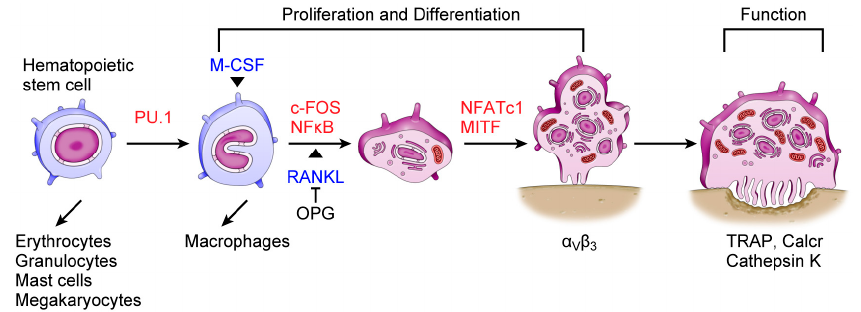
Figure 1. Schematic view of osteoclast differentiation. Osteoclasts are derived from hematopoietic stem cells. Cytokines macrophage colony-stimulating factor (M-CSF) and receptor activator of nuclear factor κ B ligand (RANKL) are essential for osteoclastogenesis. Binding of RANKL to its receptor, receptor activator of nuclear factor κ B (RANK), activates nuclear factor of activated T cells, cytoplasmic 1 (NFATc1), which is a master regulator of osteoclastogenesis. NFATc1 works with other transcription factors, such as activator protein-1 (AP-1), PU.1, and microphthalmia-associated transcription factor (MITF) to induce various osteoclast-specific genes, such as TRAP, Calcr, and Cathepsin K. RANK-RANKL interaction is inhibited by the decoy receptor osteoprotegerin (OPG) expressed by stromal cells and osteoblasts. Blue, cytokines essential for osteoclastogenesis; red, transcription factors.